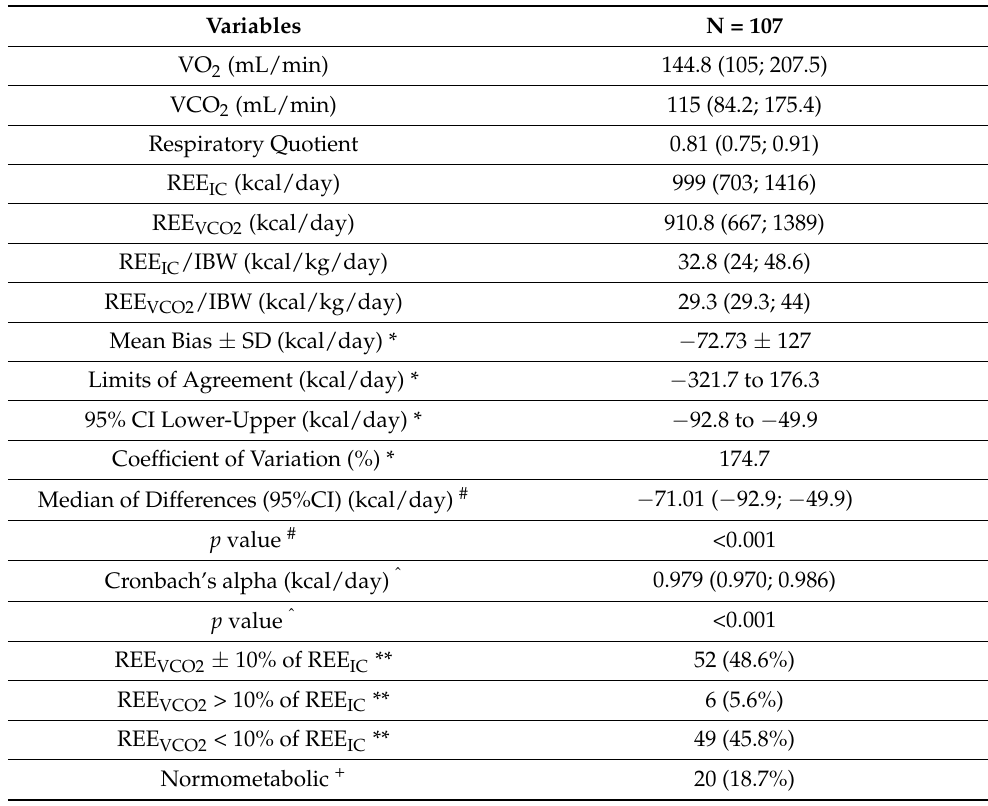
Table 2. Comparison analysis between the VCO 2 derived values and the resting energy expenditure measured by indirect